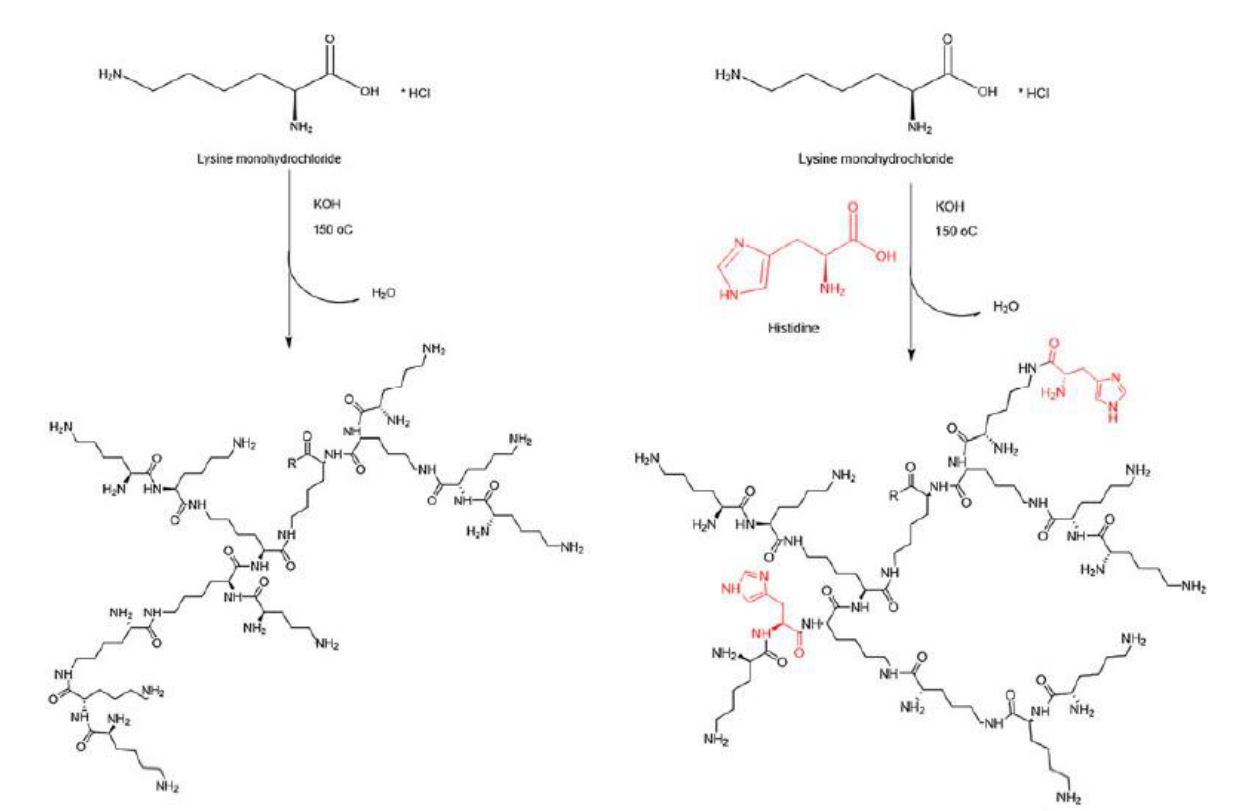
Figure 9. Thermal polycondensation of L -lysine HCl in the absence ( left ) and presence of histidine ( right ). Histidine is copolymerized into the hyperbranched structure and reduces the flexibility of the branches; reproduced from Alazzo et al. [131].